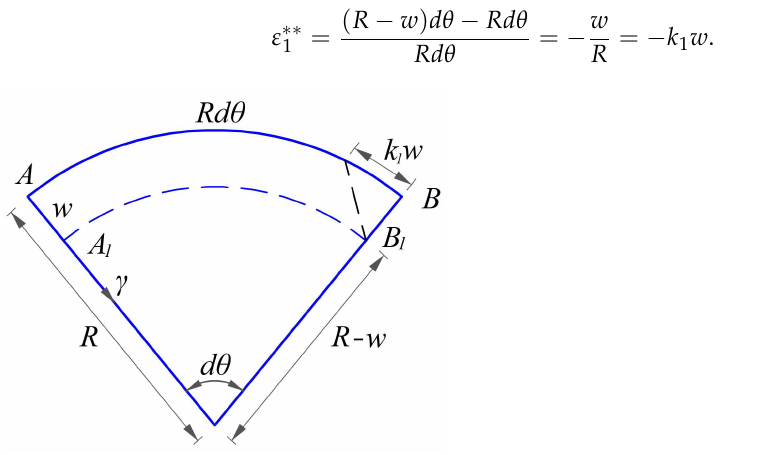
Figure 4. The strain ε 1** due to the change in the curvature radius of shell introduced by w .